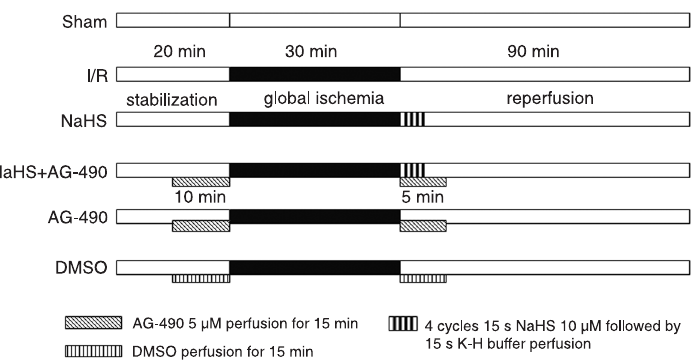
Figure 1. Schematic diagram depicting the experimental protocol (N = 14). Sham = Time-matched reperfusion; I/R = ischemia/reperfusion; NaHS = sodium hydro- sulfide postconditioning; AG-490 = specific inhibitor of JAK2; DMSO = dimethyl